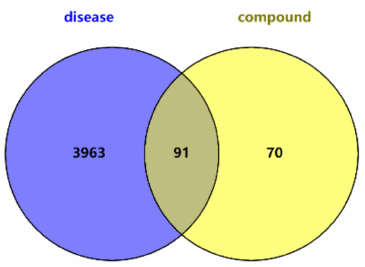
Figure 2. Venn diagram identifying disease and compound target